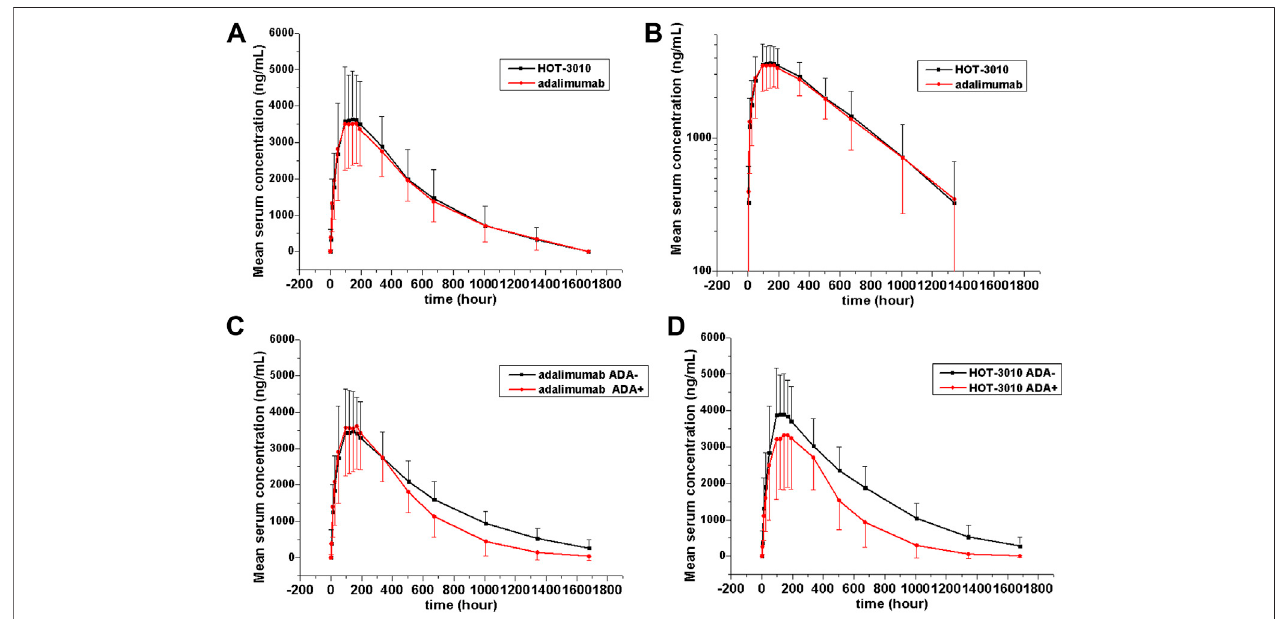
FIGURE 1 | Serum drug concentration-time pro fi le of adalimumab and its biosimilar HOT-3010 b y treatment following a single subcutaneous injection of 40 mg adalimumabandHOT-3010.DataarepresentedasMeanvalues ± standarddeviation (A) ;log10meanvalues (B) ;MeanvaluesofADA-positiveand-negativeindividuals from the HOT-3010 group (C) ; Mean values of ADA-positive and -negative individuals from the adalimumab group (D) .